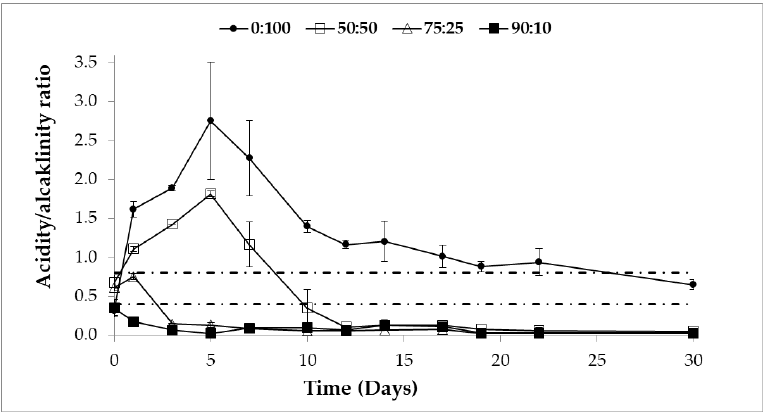
Figure 4. Evolution of the Acidity/Alkalinity ratio. The relationship between the total content of VFAs and the alkalinity shows a dif- ferent trend for the different mixtures tested. Thus, in Figure 4 it can be observed that, as the percentage of CM in the mixtures increases, the maximum value reached in the Acidity/Alkalinity ratio decreases. Zhao and Viraraghavan [35] reported that if the acid- ity/alkalinity ratio exceeds 0.8, the pH drops sharply followed by a clear inhibition in methane production and the process fails. Increases above 0.3–0.4 indicate a system failure and the need for a corrective action. A suitable ratio is considered to be between 0.1 and